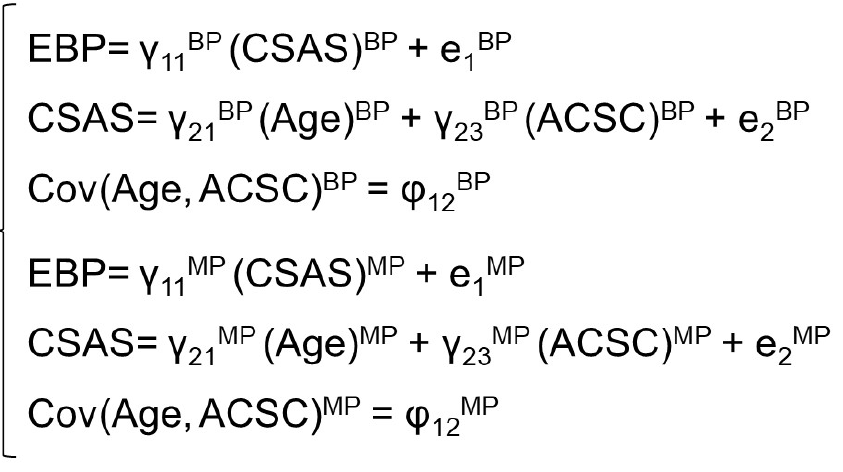
Figure 2. The formal form of the structural equation model. BP—bachelor’s programme, MP—mas ‐